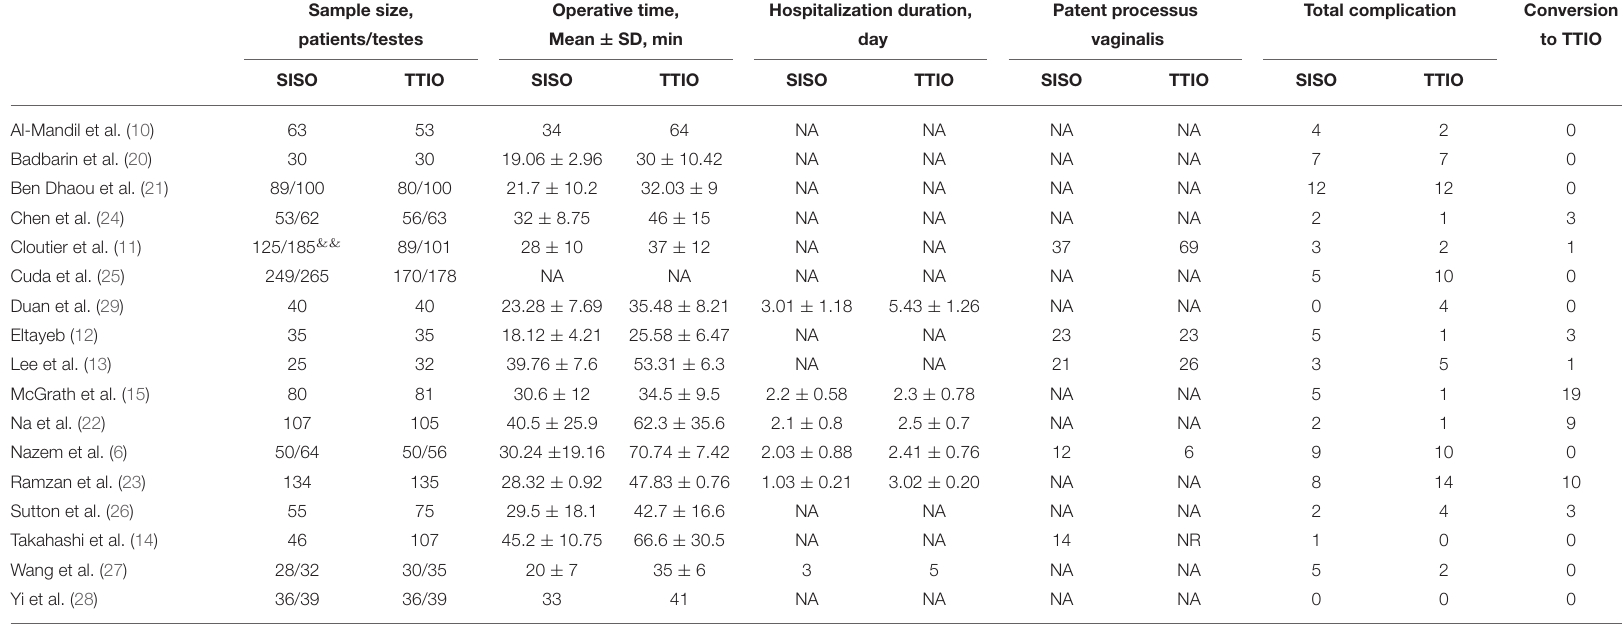
SISO indicates single-incision scrotal orchiopexy; TTIO, traditional two-incision inguinal orchiopexy; NA, not available. && 81/125 low scrotal single-incision orchiopexy and 44/60 high scrotal single-incision